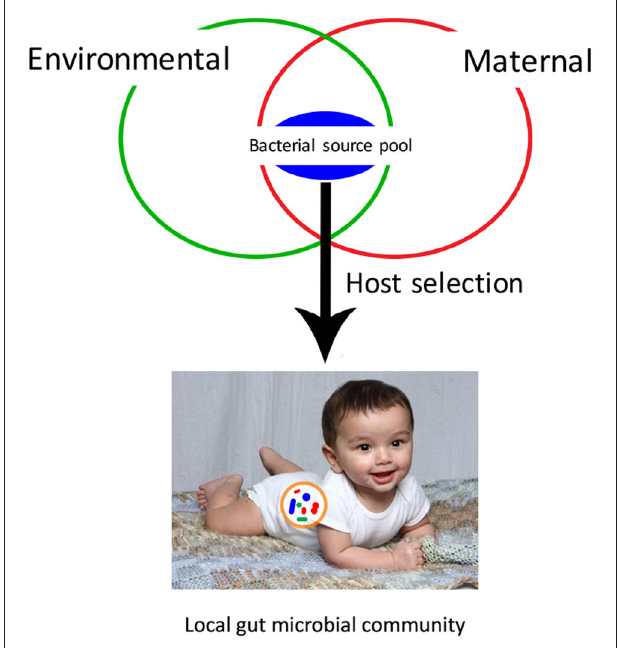
is comprised of both maternal microbes, transmitted vertically, and environmental microbes, transmitted horizontally. The development of the local community is shaped primarily by host selection, based on interactions between host and bacterial